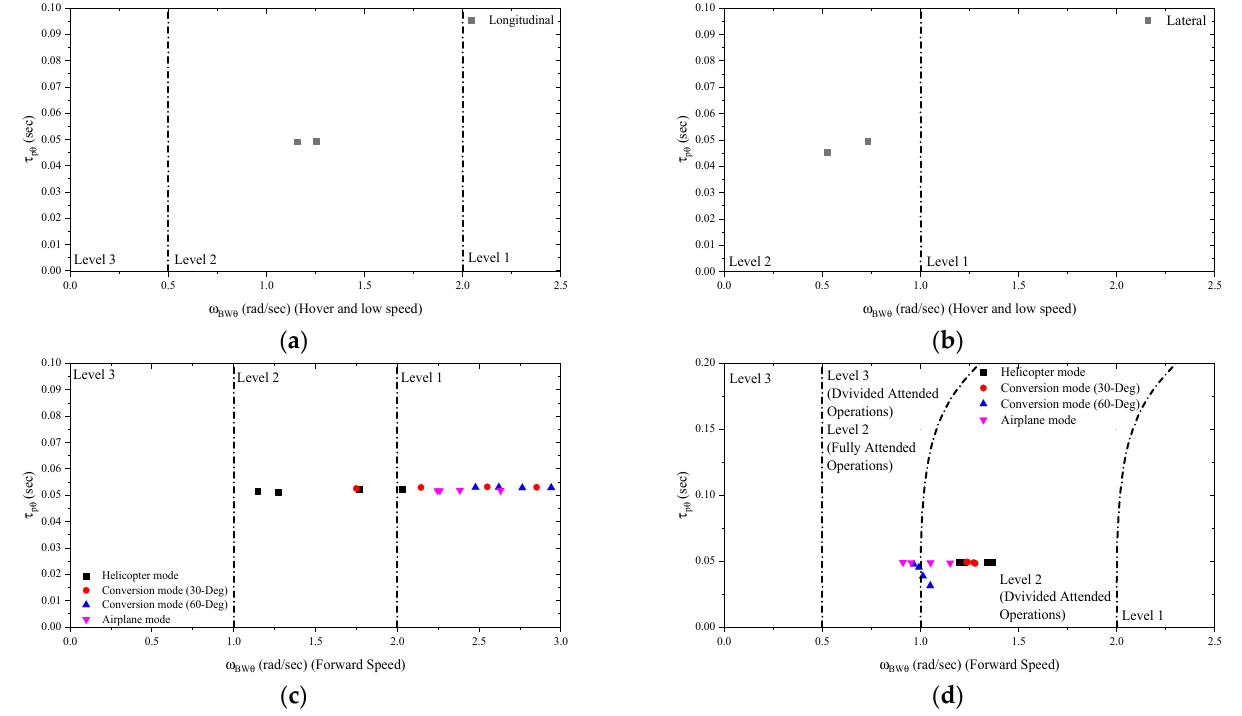
Figure 2. The bandwidth and phase delay requirements in different flight ranges. ( a ) Longitudinal- Hover and low-speed flight; ( b ) Lateral-Hover and low-speed flight; ( c ) Longitudinal-forward flight; ( d ) Lateral-forward flight.